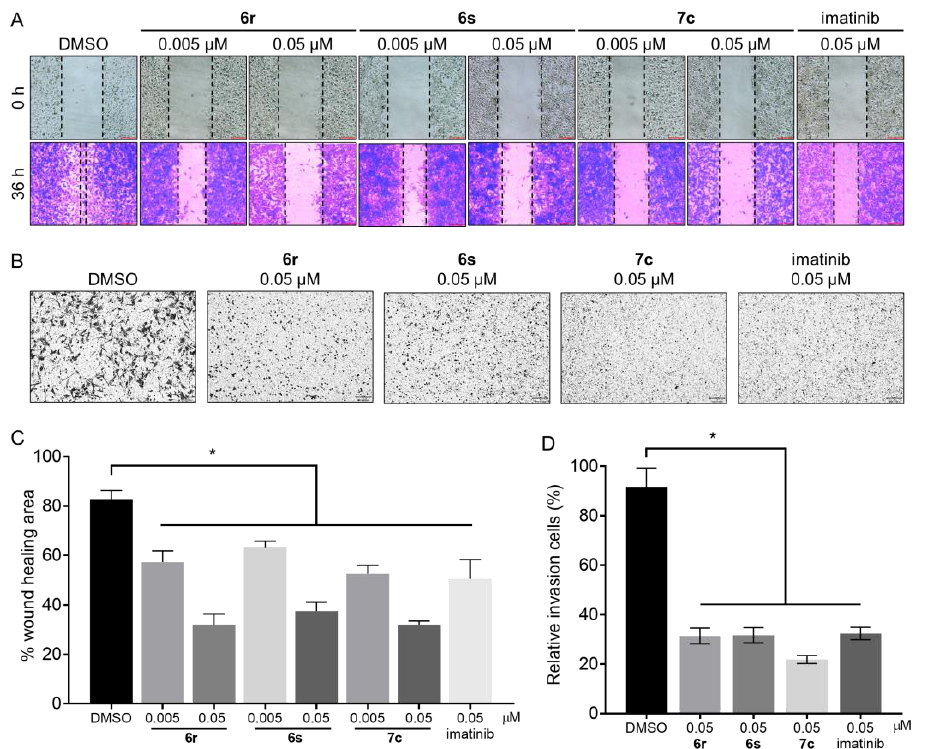
Figure 6. Effects of 6r , 6s , 7c , and imatinib on migration and invasion. ( A ) Cell migration of GIST-T1 cells was inhibited by treatment (36 h) with 6r , 6s , and 7c (0.005 µ M and 0.05 µ M). ( B ) Invasion of GIST-T1 cells was inhibited by treatment (48 h) with 6r , 6s , 7c , and imatinib (0.05 µ M). ( C , D ) Percentage wound healing area and relative invasion cells were calculated using ImageJ. (average ± S.D., n = 3 one-way ANOVA and Tukey’s multiple comparisons test; * p < 0.05).